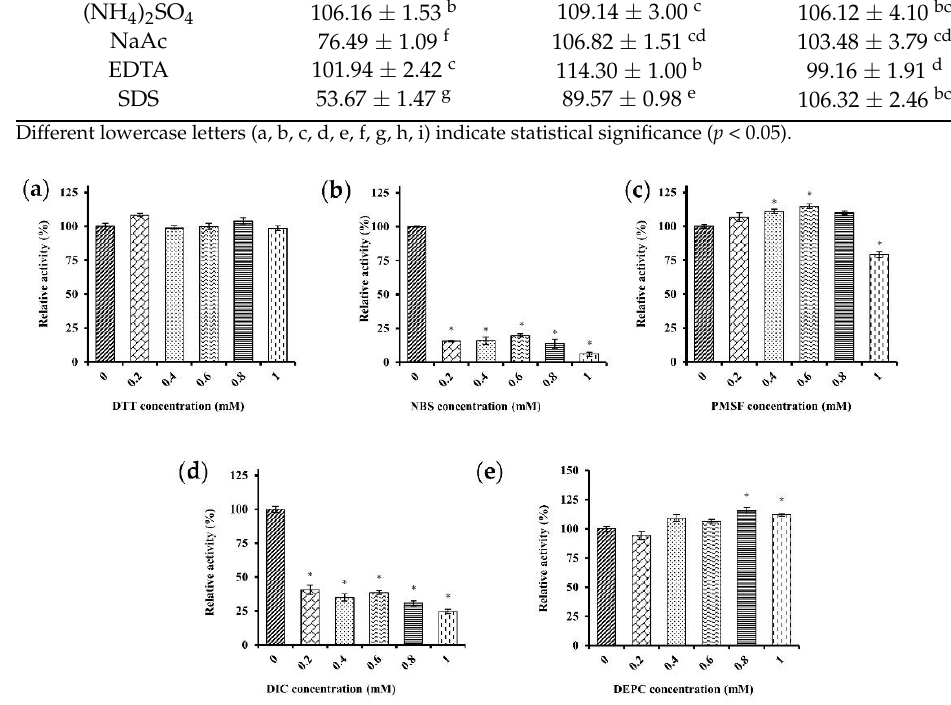
Figure 4. Effect of side modification reagents on the activity of ORG: ( a ) DTT, ( b ) NBS, ( c ) PMSF, ( d ) DIC, ( e ) DEPC. In each figure, “0 mM” indicates control. “*” represents significant difference in activity in comparison to control ( p < 0.05, Student’s t -test).